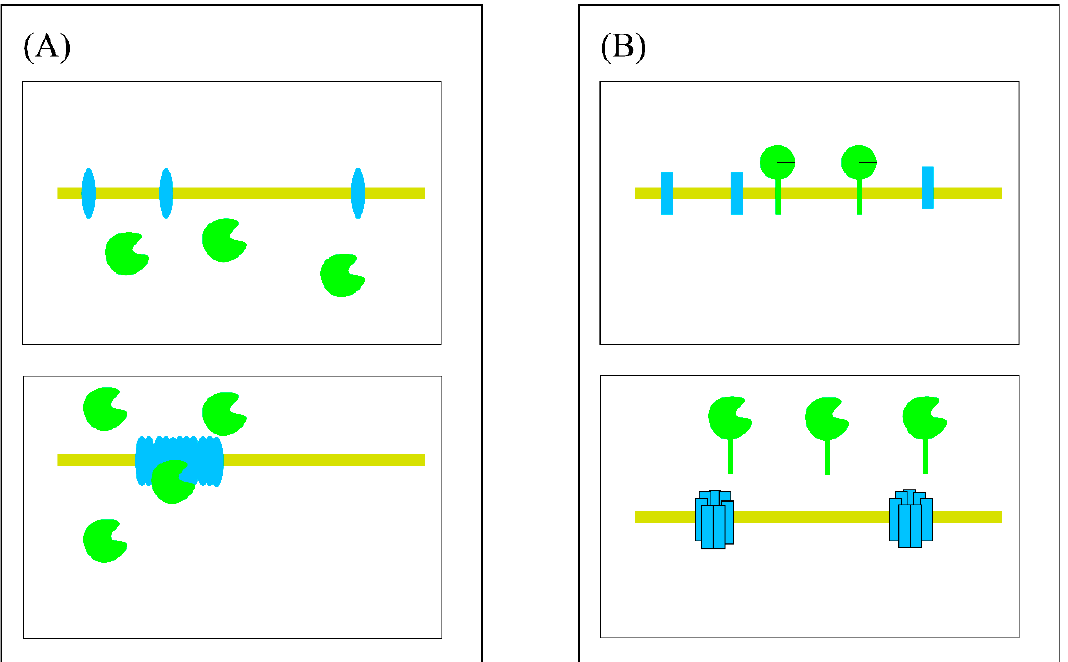
Figure 2. Two pathways to murein degradation. The inner membrane (IM) is shown by the yellow rectangle. ( A ) Classic holin–endolysin pathway: holin proteins (blue ovals) and endolysin (green ovals with open active sites). ( B ) SAR endolysin and pinholin pathway: pinholin (blue rectangles) and SAR-endolysin (green ovals with SAR domains). In the phage synthesis stage, holin or pinholin proteins are continuously synthesized and accumulate in the cytoplasm and IM in the form of a dimer. At the same time, endolysin protein is folded to form peptidoglycan-lytic enzymes and accumulates in the cytoplasmic matrix. SAR endolysin accumulates in the cytoplasm and IM without activity. When those proteins accumulate to a critical value, endolysin is released to lyse the peptidoglycan layer, and SAR endolysin refolds its conformation to obtain the active enzyme.